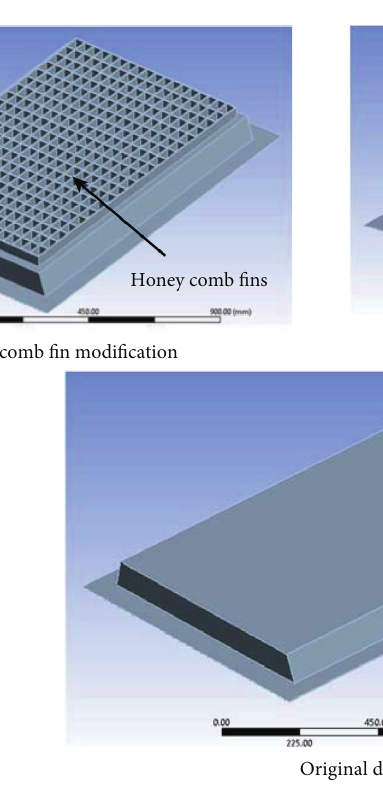
Figure 7: Hot plate surface geometric models with design modification (different fin